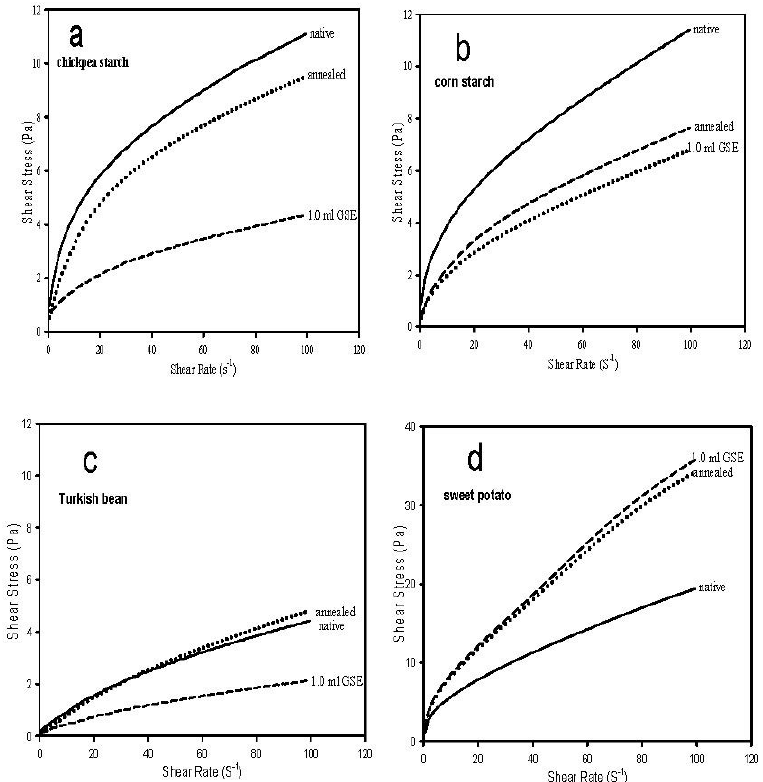
Figure 1. Shear rate/shear stress of native, annealed and treated with germinated sorghum extract (GSET) chickpea ( a ), corn ( b ), Turkish bean ( c ) and sweet potato ( d ) starches.